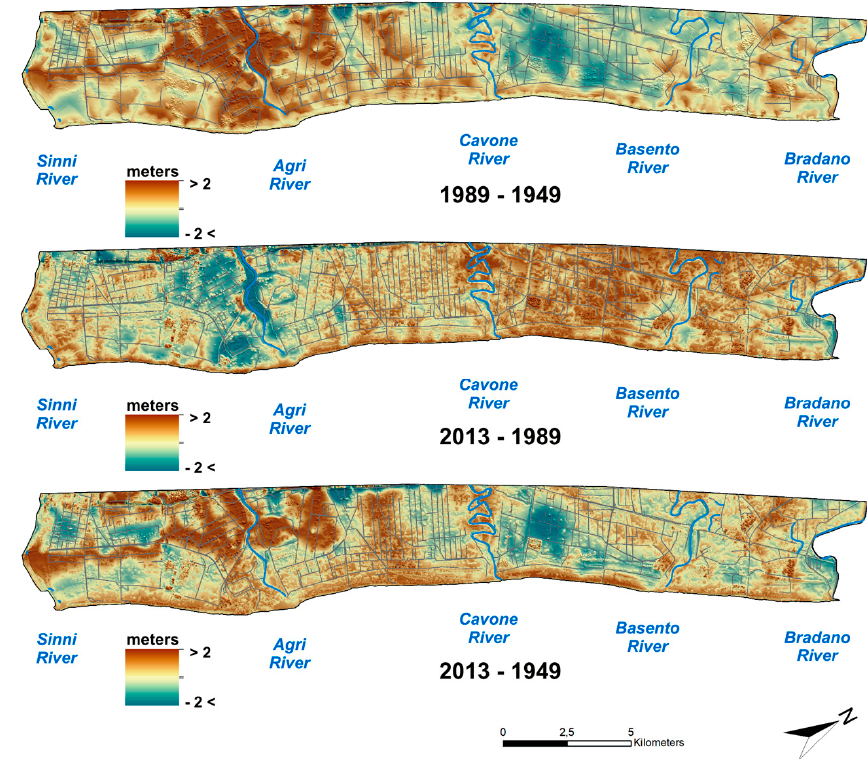
Figure 7. Erosion/deposition dynamics for the periods 1949–1989, 1989–2013, and 1949–2013. Reclamation channels were reported in gray